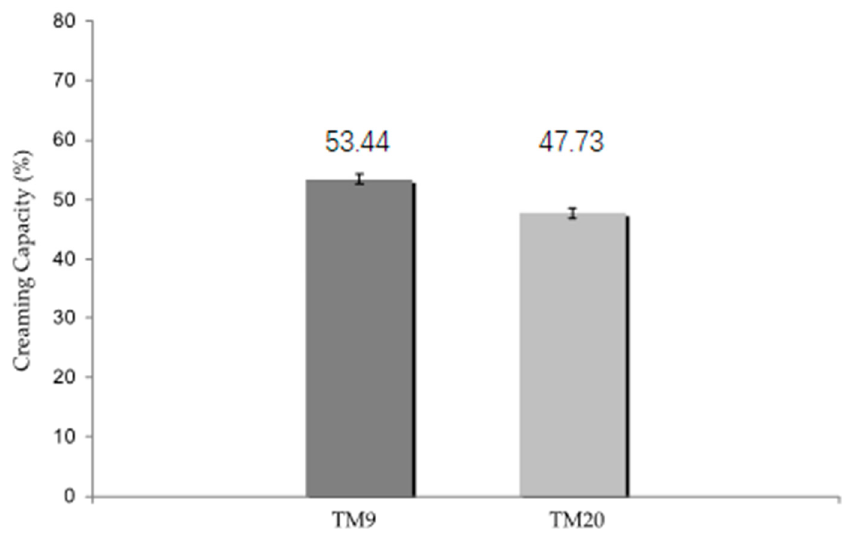
Figure 1. Least square mean values of creaming capacity of the partially skimmed milk (PS-milk) obtained from bulk milk kept at the farm at 9 °C (TM9) and at 20 °C (TM20), TM9 and TM20 means values differ with a p -value ≤ 0.05.